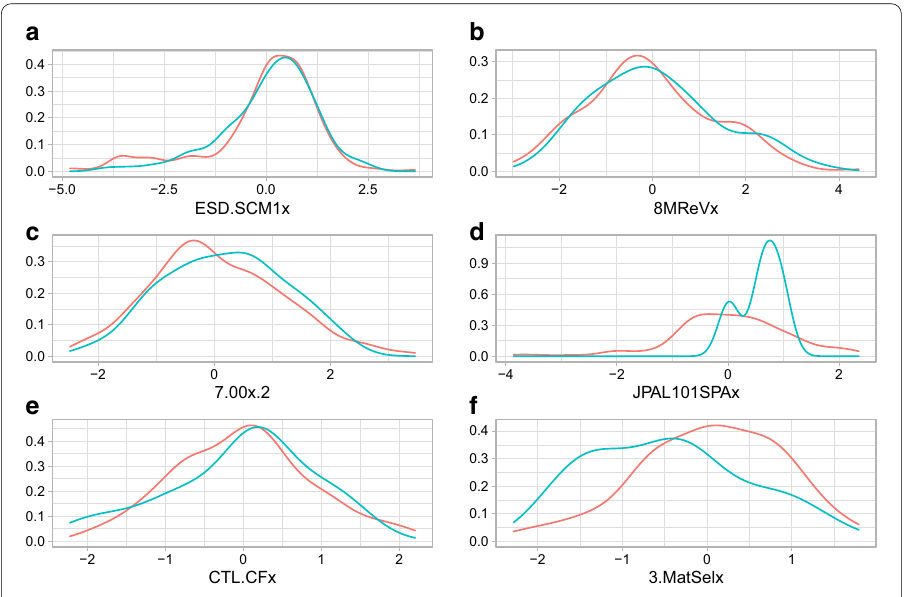
Fig. 4 Estimated IRT ability parameters by HDI (blue